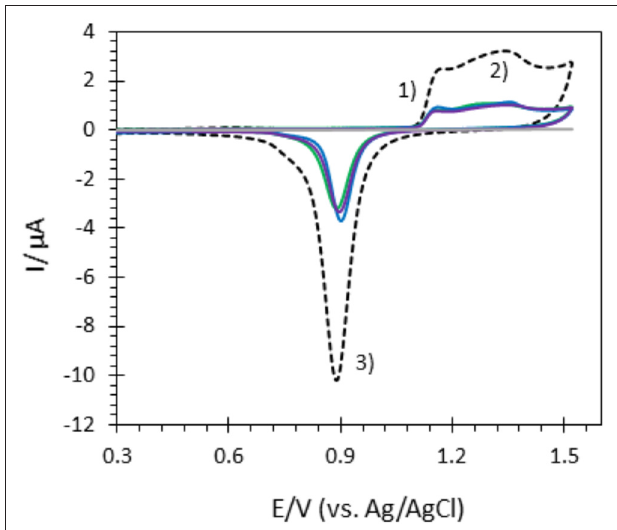
FIGURE 3 | CVs of bare ITO (gray), Au-film@ITO (black dashed), and AuNP@ITO electrodes prepared from 20nm (green), 30nm (blue) and 40nm (purple) Au films in 0.05M H 2 SO 4 . Scan rate 100